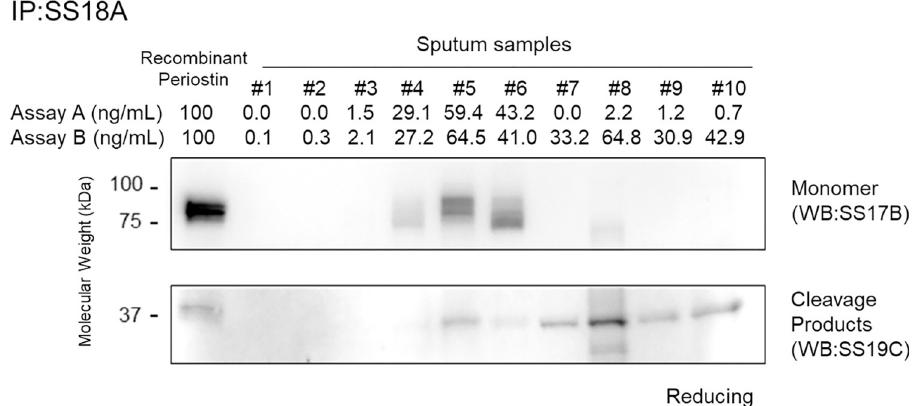
Fig 5. Evidence of intact and cleaved periostin products in sputum from asthma patients. Western blot showing intact and/or cleaved periostin products as well as estimated periostin values obtained by ELISA. The results of Assay A or Assay B in sputum samples from 10 asthma patients are depicted. In the Western blotting image, the monomeric periostin represents the reaction with the SS17B antibody and the cleaved product with the SS19C antibody.